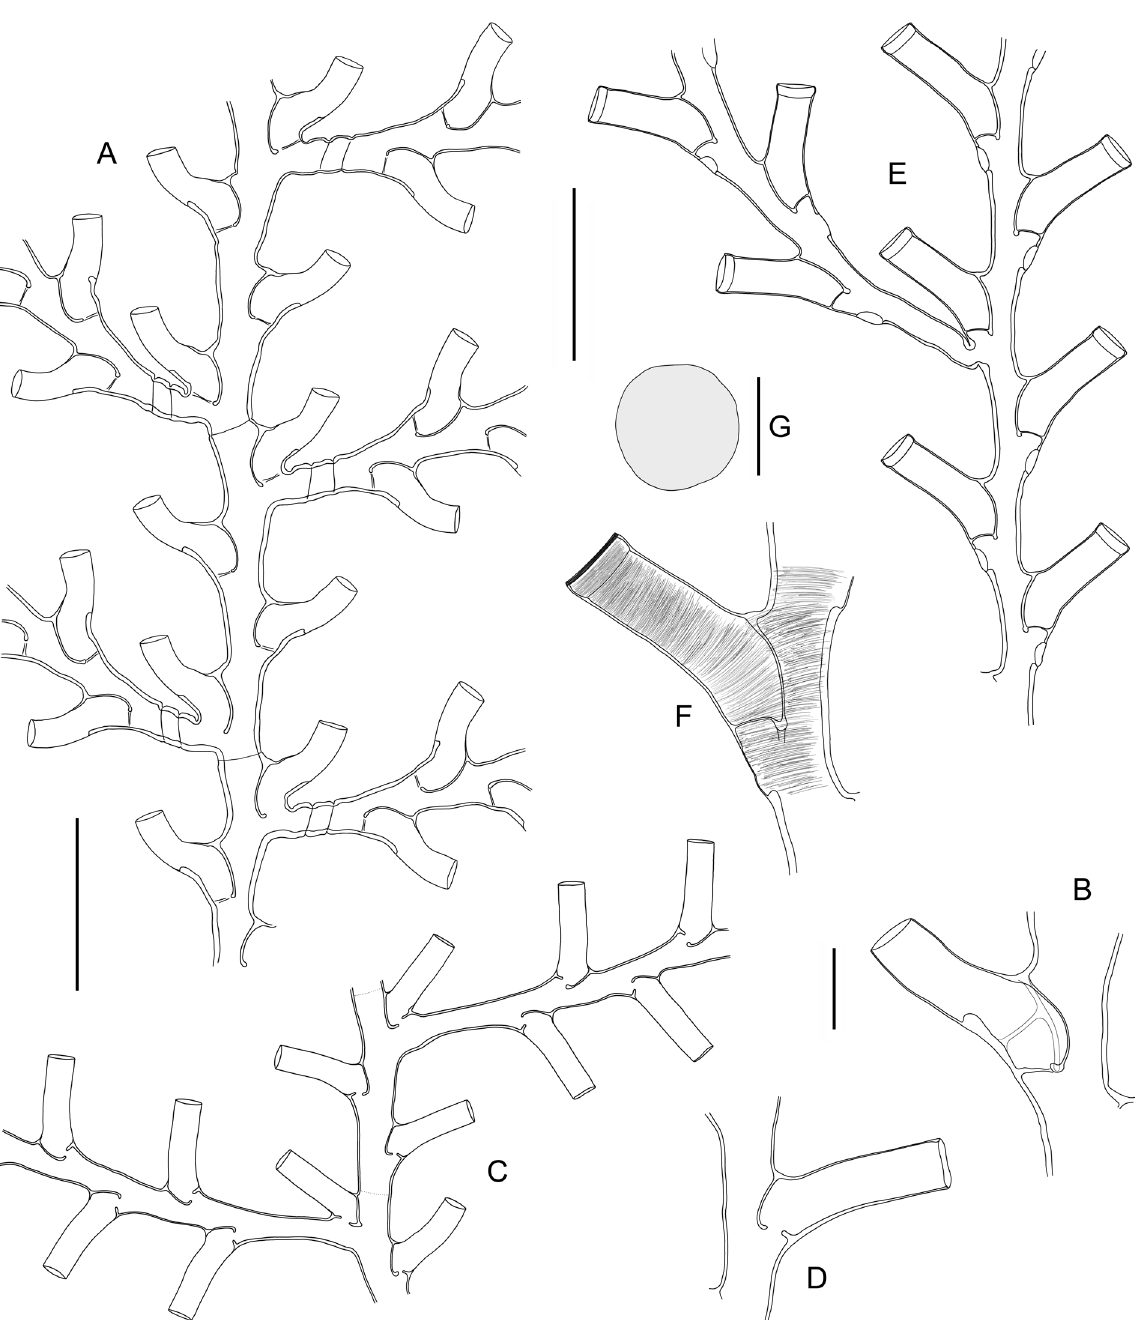
Fig. 4. — A – B . Solenoscyphus candelabrum gen. et sp. nov. A . Portion of stem with basal parts of five cladia. B . Hydrotheca, showing internal projections of the perisarc. — C – D . Solenoscyphus decidualis gen. et sp. nov. C . Portion of stem with basal parts of two consecutive cladia. D . Hydrotheca. — E – G . Solenoscyphus striatus gen. et sp. nov. E . Portion of stem with basal part of a side branch. F . Hydrotheca, showing the characteristic striation of the perisarc. G . Operculum. Scale bars: A, C, E = 2 mm; B, D, F = 500 µm; G = 300